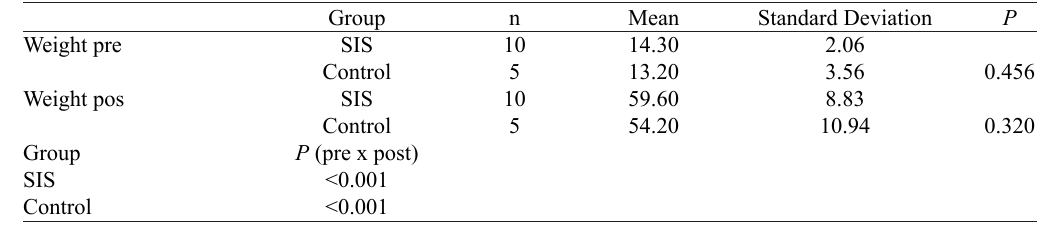
Table 1. Inter- and intra-group weight analysis (kg) between pre-operative evaluation and 60 days after surgery. Weight